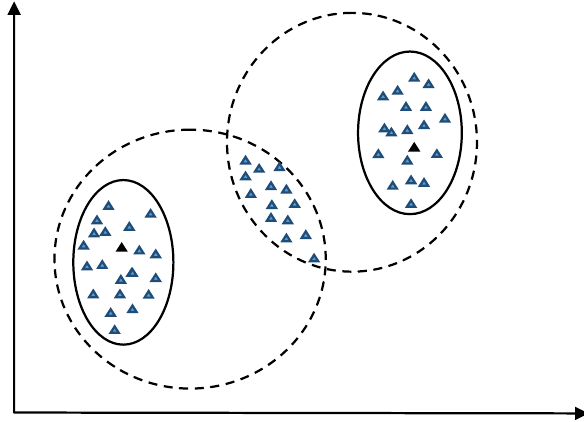
Fig. 1 Rough K-means centroid based